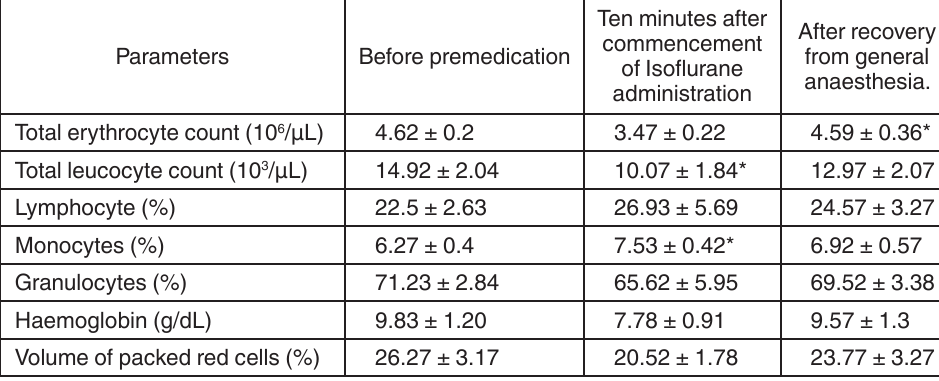
table 1. Observations on haematological parameters (Mean ± SE) n=6